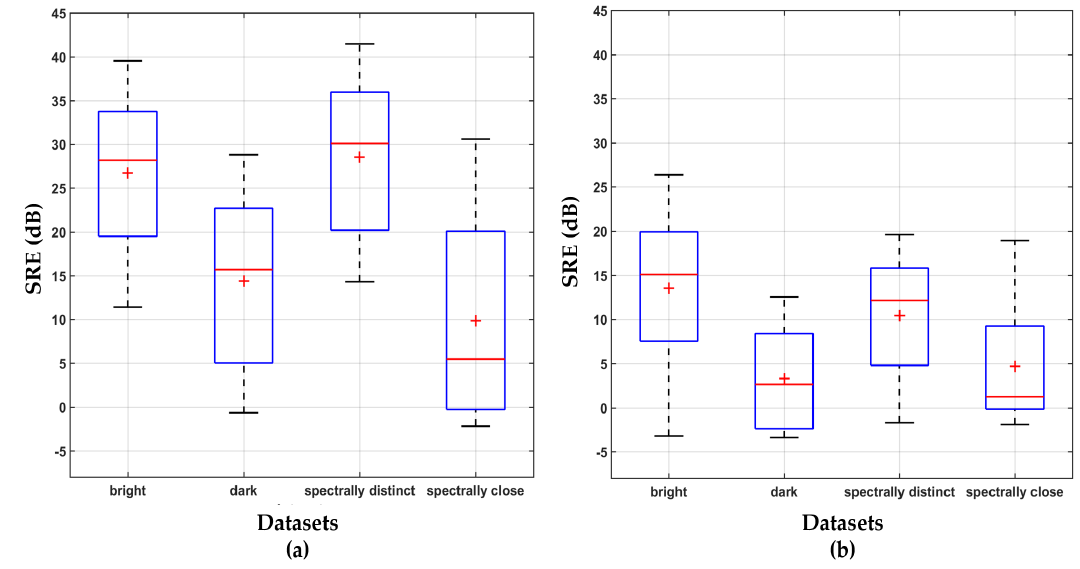
Figure 17. Effects of scattering on reflectance estimates in ( a ) and on abundance estimates in ( b ) for various